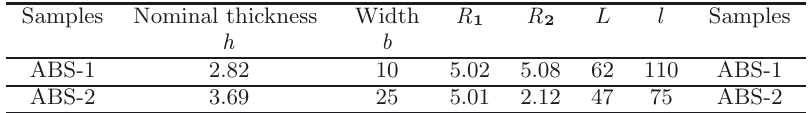
Table 1. Sample dimensions.